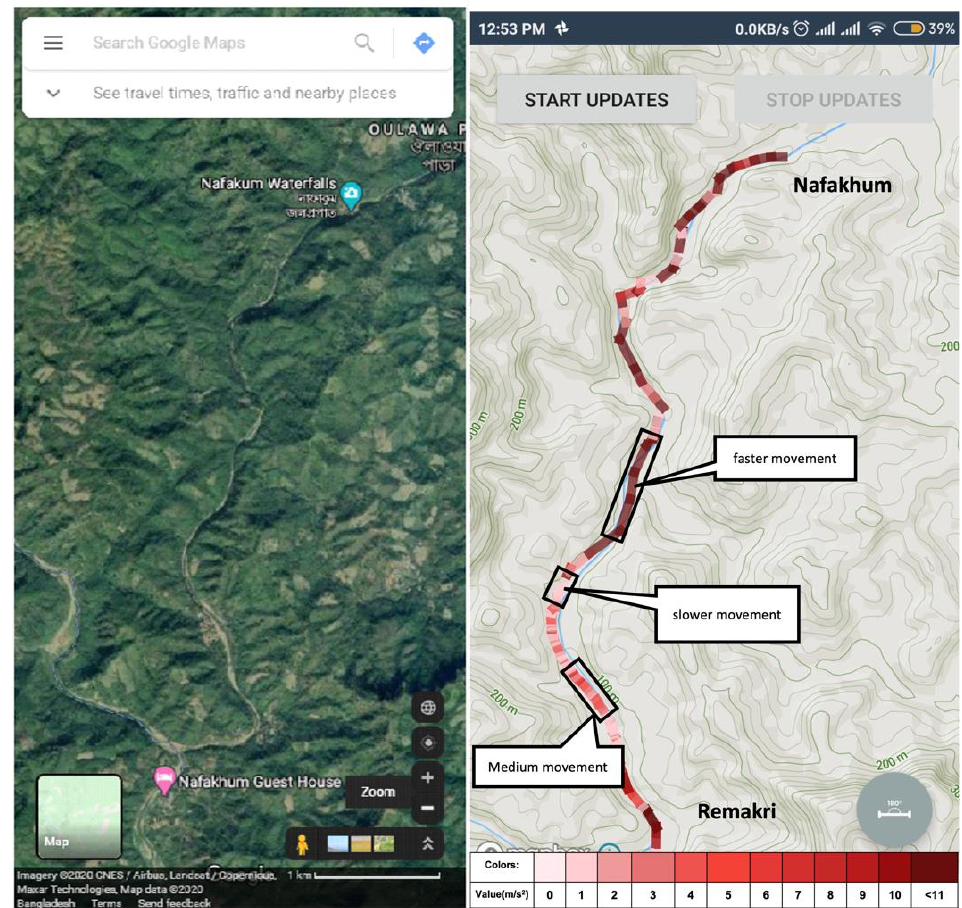
Figure 11. Top view from Google Maps ( Left ) and the top view from the proposed app ( Right ).